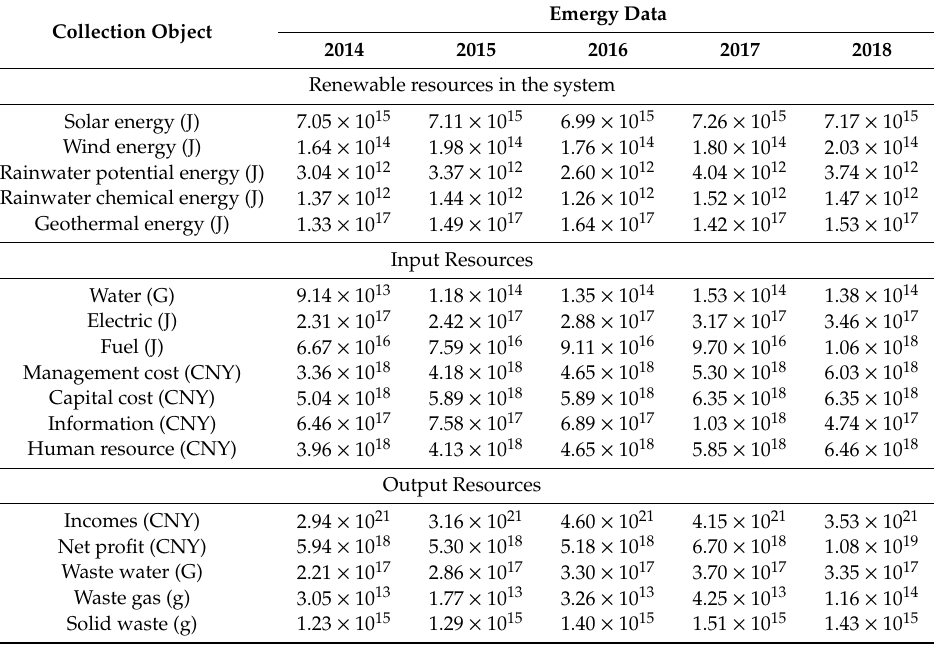
Table 3. The emergy data of the logistics park in 2014–2018.